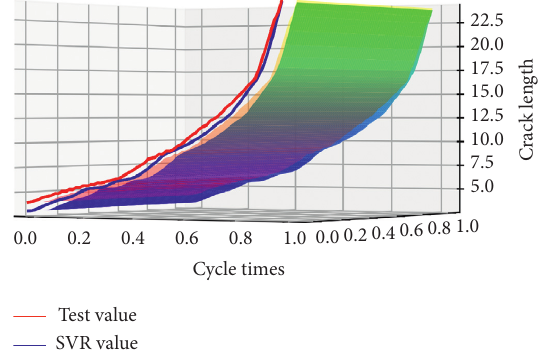
Figure 16: Prediction of crack length with constant amplitude by